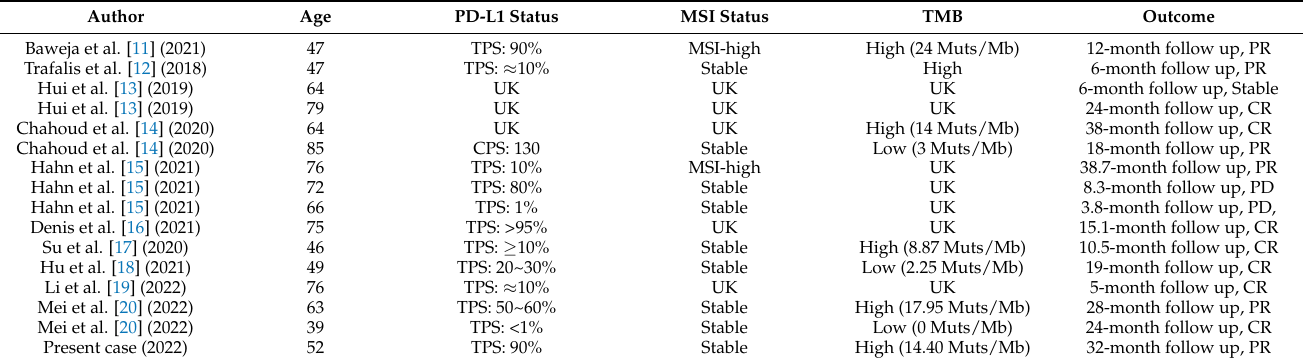
Table 1. Clinical features of reported